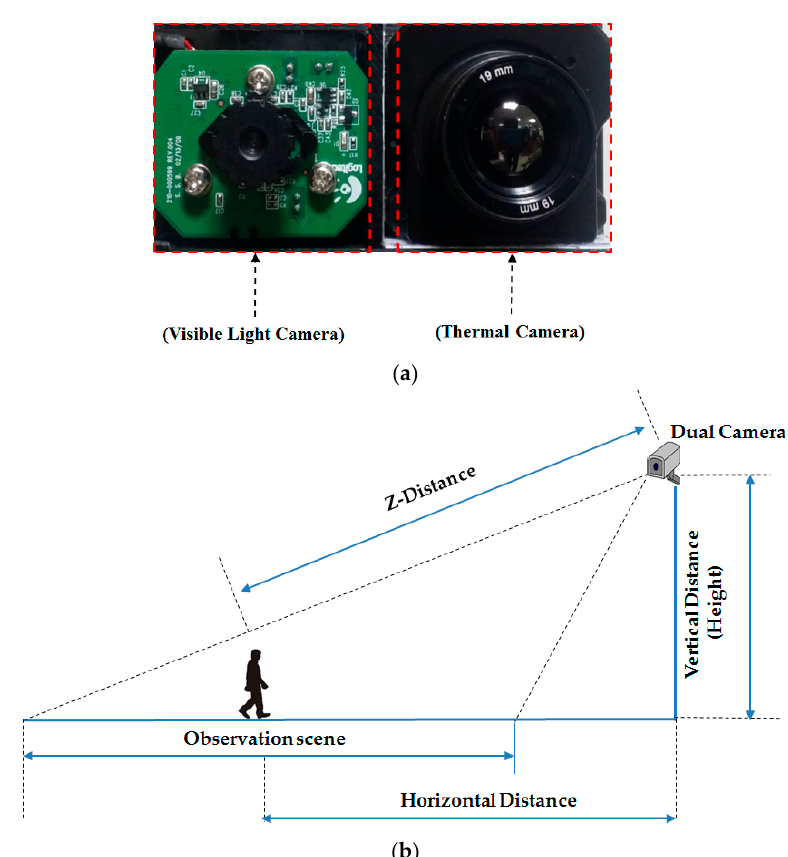
Figure 6. Dual visible light and thermal camera and experimental setup for data acquisition in our study: ( a ) the dual visible light and thermal camera; and ( b ) the experimental setup.